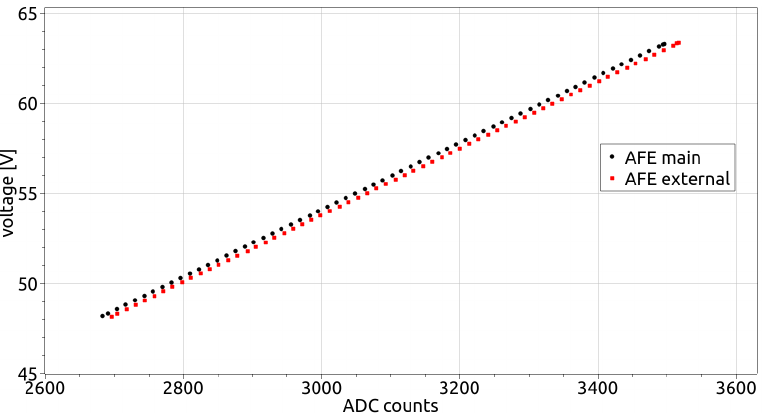
Figure 18. AFE internal voltmeter calibration comparison between Main and External AFEs.